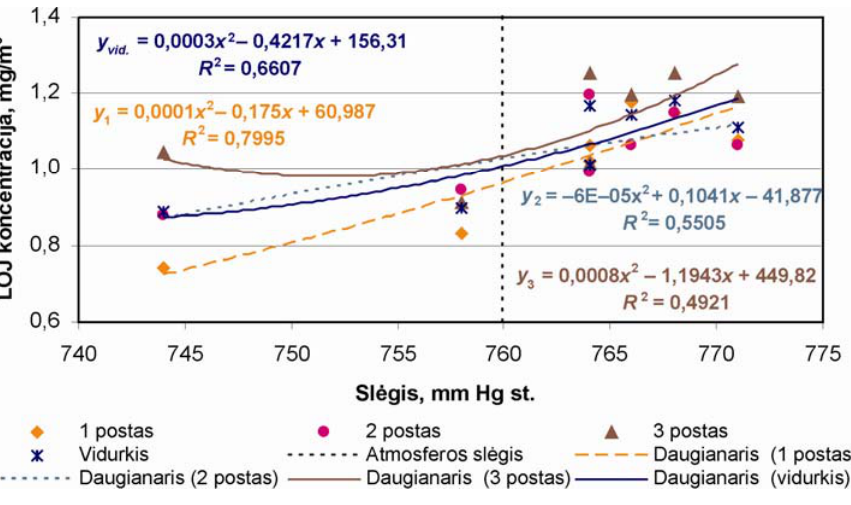
Fig 11. Dependence of VOC concentration in ambient air on atmospheric pressure (10-day results)